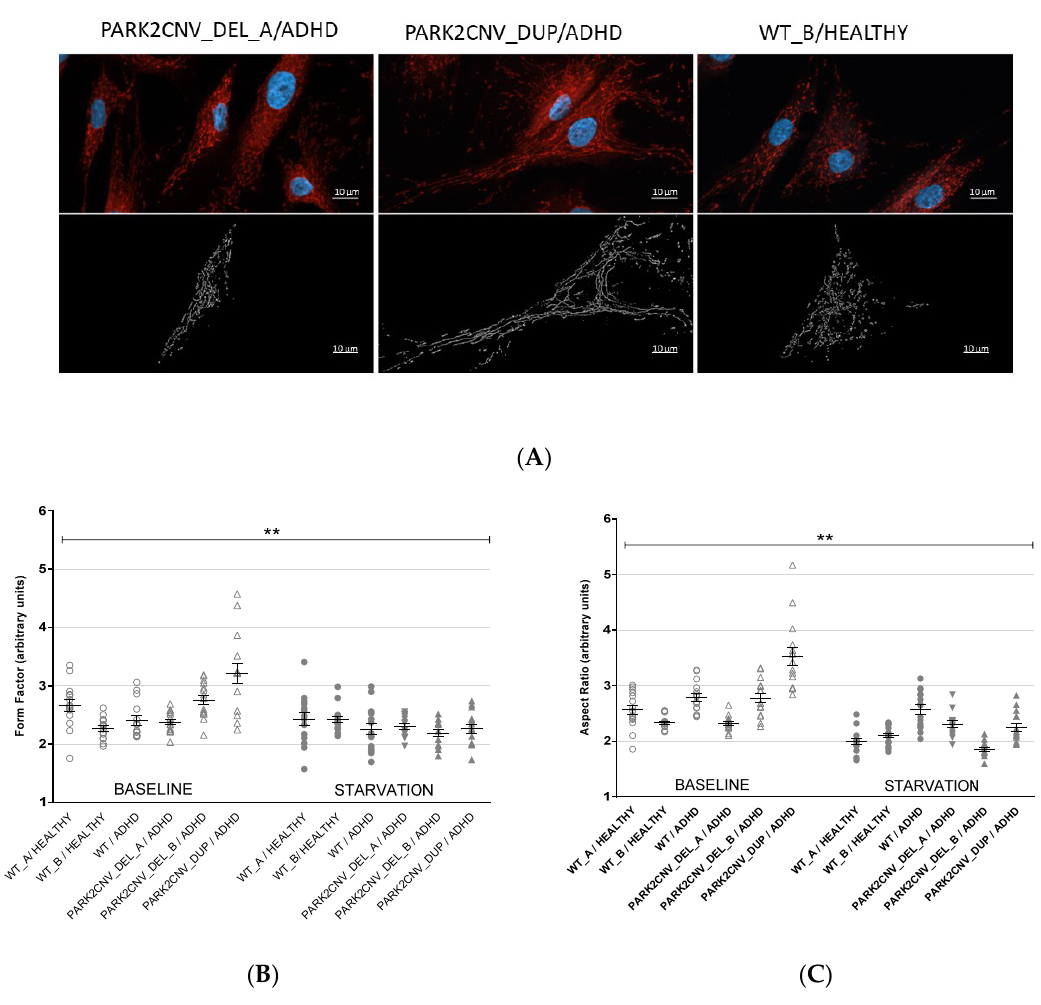
Figure 1. ( A – C ): Mitochondrial network analysis. ( A ) Mitochondrial staining (MitoTracker Red CMXRos) in fibroblast cell lines under baseline conditions, and mask of the semi-automated digital image analysis (Fiji / ImageJ) showing different types of network morphology. These images demonstrate a tubular elongated mitochondrial shape (PARK2CNV_DUP / ADHD) and a fragmented round-shaped mitochondrial network (WT_B / HEALTHY and PARK2CNV_DEL_A). Scale bars 10 µ m. Graphical representation of the form factor (FF) (1B) and Aspect ratio (AR) (1C). The values were obtained by analyzing 15 cells per line / condition from two independent experiments. The dots represent the mean AR and FF values of all the mitochondria present in each fibroblast cell. In both cases there seem to be a more elongated mitochondrial shape and tubular branching in the PARK duplication carrier (PARK2CNV_DUP / ADHD) compared to the other cells (PARK2CNV_DEL_A / ADHD, PARK2CNV_DEL_B / ADHD, WT_A. WT_B / HEALTHY as well as WT / ADHD). ANOVA was calculated, level of significance was set at p = 0.05. ** p ≤ 0.01. Data are shown as mean ± SEM.